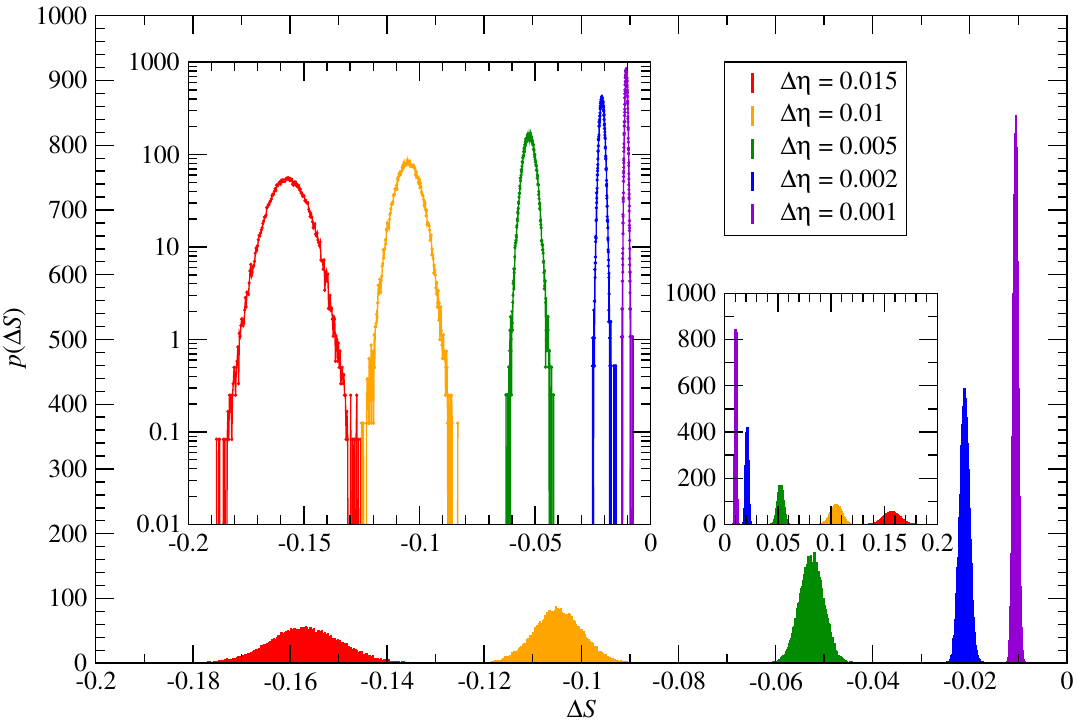
Figure 1 . Distribution of the Euclidean action di(cid:11)erence (cid:1) S in non-equilibrium simulations of the SU(2) gauge theory in a hypercubic box of linear size L = 5 a at (cid:12) = 2 : 7124, with the boundary (cid:12)elds speci(cid:12)ed in eq. (2.10). The histograms show the distribution of (cid:1) S induced by a \direct" non- equilibrium transformation in which (cid:17) is varied from (cid:17) = (cid:25)= 4 to (cid:17) = (cid:25)= 4 + (cid:1) (cid:17) through a sequence of n = 200 quenches, for di(cid:11)erent values of (cid:1) (cid:17) . The larger inset shows the same distributions qq using a logarithmic scale for the vertical axis. In the smaller inset, the results from \reverse" transformations, from (cid:17) = (cid:25)= 4 + (cid:1) (cid:17) to (cid:17) = (cid:25)= 4, are